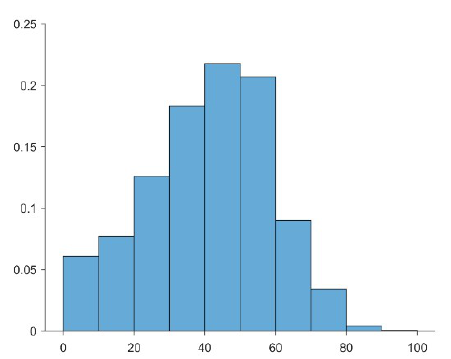
Figure 7. Histogram of global average percent cloud cover for Landsat-8 observations. The bin widths of histogram are defined at 10% intervals, and the percentages of each bin denote the number of observations compared with the total number. The data are from Figure 6.